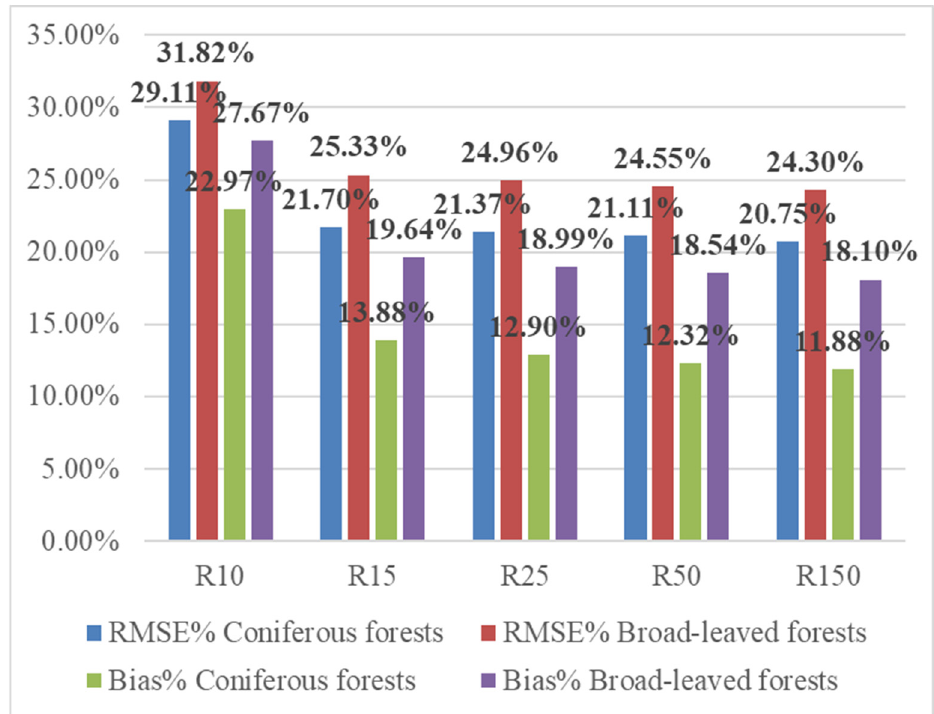
Figure 7. The accuracy (root mean square error (RMSE)%, bias%) of D. pierrei height obtained under different point cloud densities and different vegetation types.